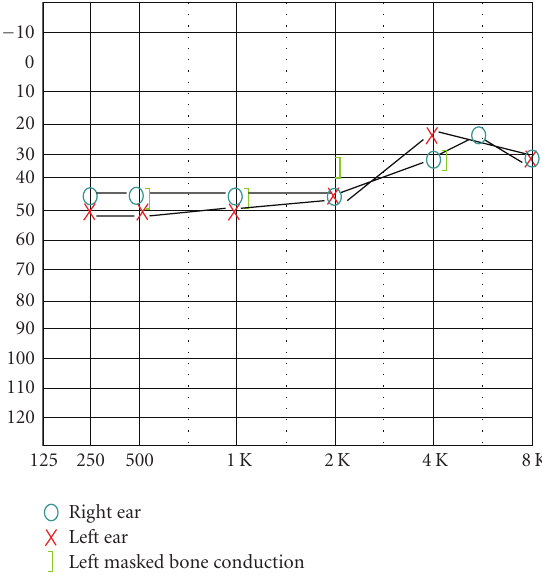
Figure 2: Audiogram following